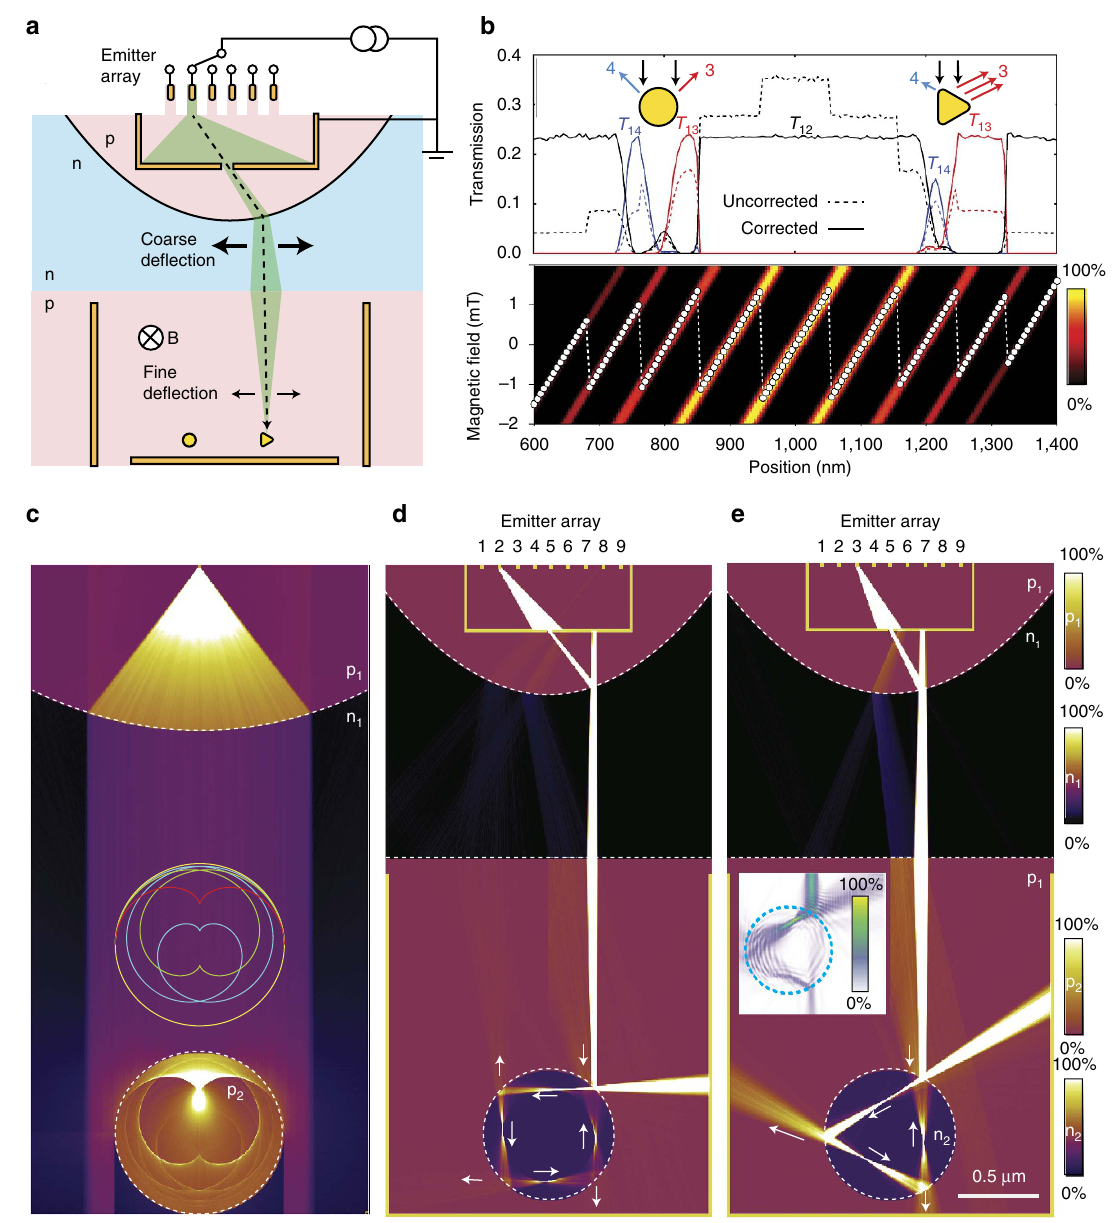
Figure 5 | DFM with multiple emitters and coaligned beam. ( a ) Illustration of the coaligned scanning DFM, where an array of emission electrodes and a parabolic p–n junction allows for lateral displacement of a vertically aligned beam of electrons. A small magnetic field provides fine adjustment of the beam position. ( b ) Transmission from emitter to electrode 2 (bottom), electrode 3 (right) and electrode 4 (left) before (dashed) and after (full lines) correction for emission current variations of the nine emitters. The lower panel shows the switching between emitter electrode (9,8,7, y ,1) and magnetic field ( y axis) needed to produce a continuous coaligned scan. ( c ) Parallel beam of electrons scattering on a circular p–n junction ( w ¼ 2.5nm), producing the well-known caustic pattern of trajectories in a circular potential (see Supplementary Note 2). ( d , e ) Injection of current directly into square and triangular closed orbits. The carriers are transmitted out at the three corners, producing well-collimated jets. Colour scales ranging from 0% (zero current density) to 100% (high current density) are used to visualize zones (p 1 , n 1 , p 2 , n 2 ) with different carrier polarity in c – e . The inset in e shows the bond current results from an atomistic transport calculation of a graphene VD with a similar ratio between diameter and l F as used in the semiclassical simulation, resulting in a current density resembling the triangular closed orbit and a current jet emission pattern qualitatively in agreement with the semiclassical simulation. The quantum transport calculations are detailed in Supplementary Note tracing 35,56 . Upscaling of the lateral dimensions as a route to of the atomistic bond current from atomistic tight-binding diminish diffraction and coherence effects will benefit directly calculations, for collimated Dirac fermion beams generated by from continued development of sample quality 2,12 . One exception parabolic lenses and narrow apertures. Three cases are presented, is the scattering of Dirac fermion beams on small objects, where to illustrate the main concepts of this work: a caustic pattern quantum coherence effects may cause significant deviations from corresponding to Fig. 5c, a triangular closed orbit in a circular the transmission signatures found from our semiclassical p–n junction with jet currents corresponding to Fig. 5e and trajectory simulations. In Supplementary Note 3 we show maps scanning of a focused beam using the magnetic field across a